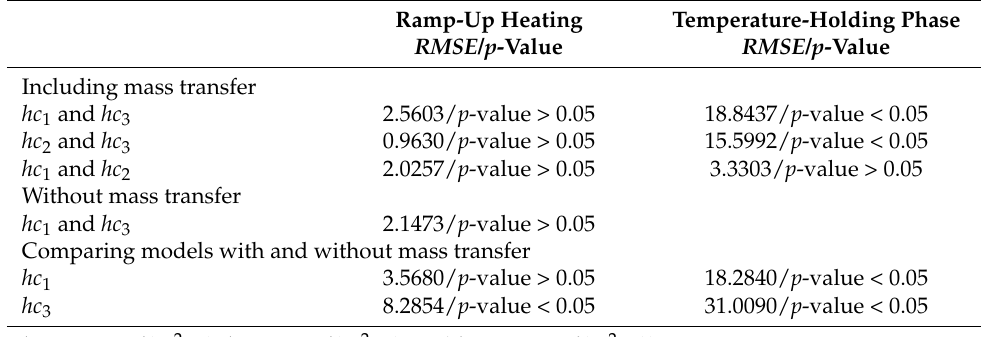
Table 6. RMSE and p -value of various comparisons of hc values of the model with and without mass